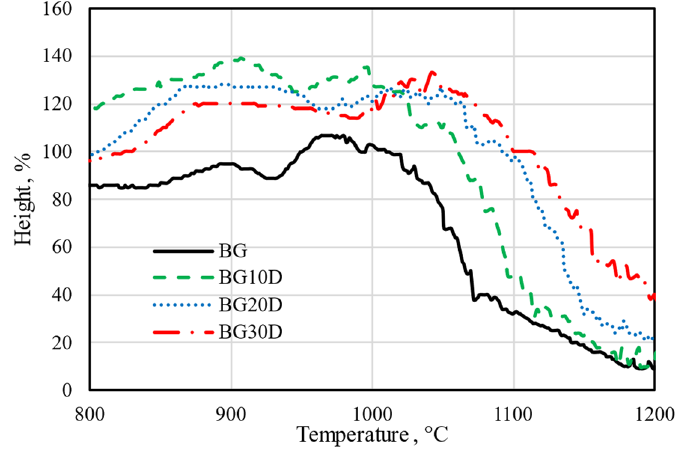
Figure 2. Sintering curves of glass foams with SLS glass (BG) and 10, 20, and 30 wt% dross (BG10D, BG20D, BG30D).